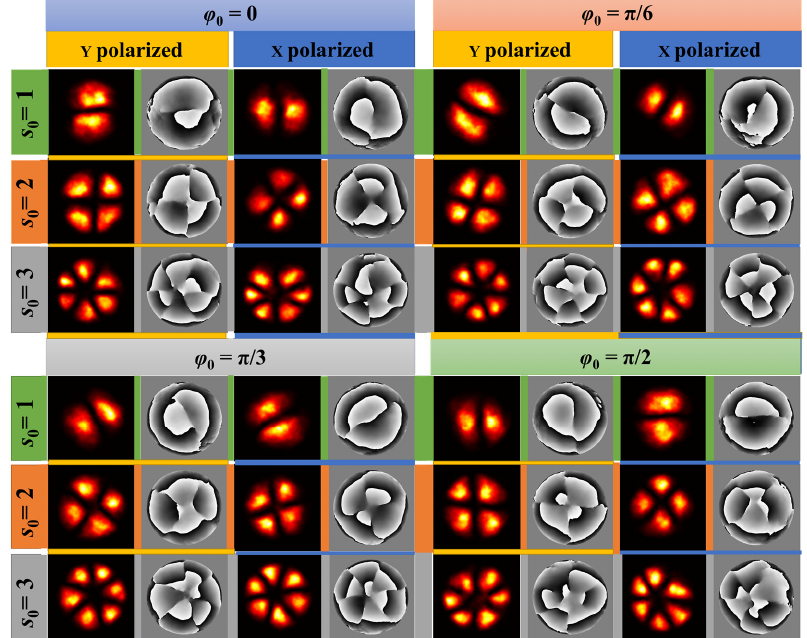
Figure 2. Intensity and phase diagrams of the components in x and y polarization directions of a cylindrically polarized LG vortex beam with different OAM mode s 0 and initial phase angle φ 0 after atmospheric turbulence propagation (parameter setting: propagation distance z = 1.5 km, Fried pa- rameter r 0 = 10 mm, wavelength λ = 1550 nm, radial mode p 0 = 0, beam width w 0 = 0.02 m).